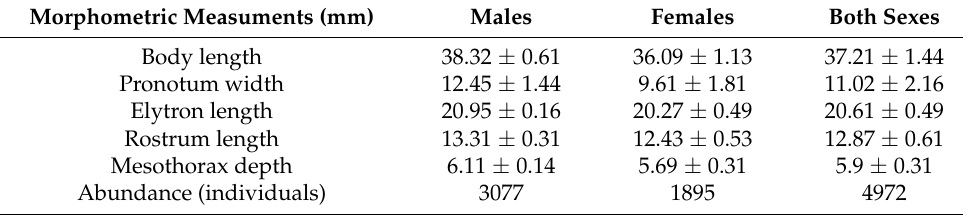
Table 1. Variation in morphological traits (mean ± SD) of R. palmarum adult populations cap- tured in ornamental palm plantations with different intensity of agricultural management in central Veracruz,